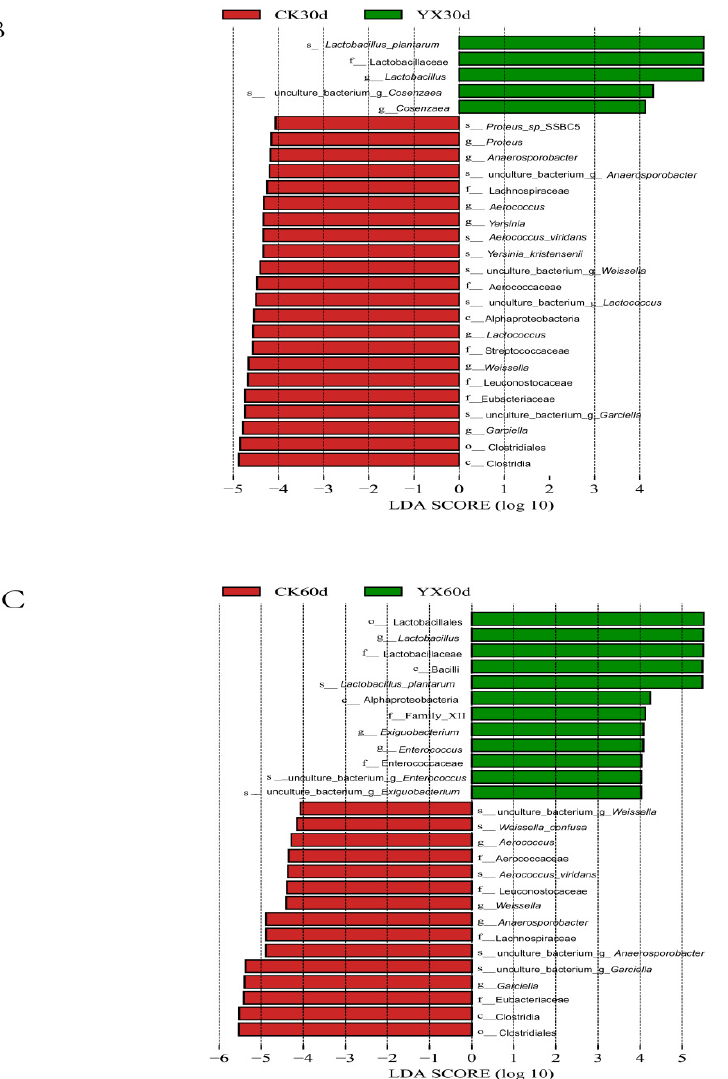
Figure 6. Comparison of microbial variations using LEfSe analysis for 15 d ( A ), 30d ( B ), and 60 d ( C ). CK, control; YX, inoculated with commercial LAB YX; the numbers following CK and YX stand for ensiled days of silage.